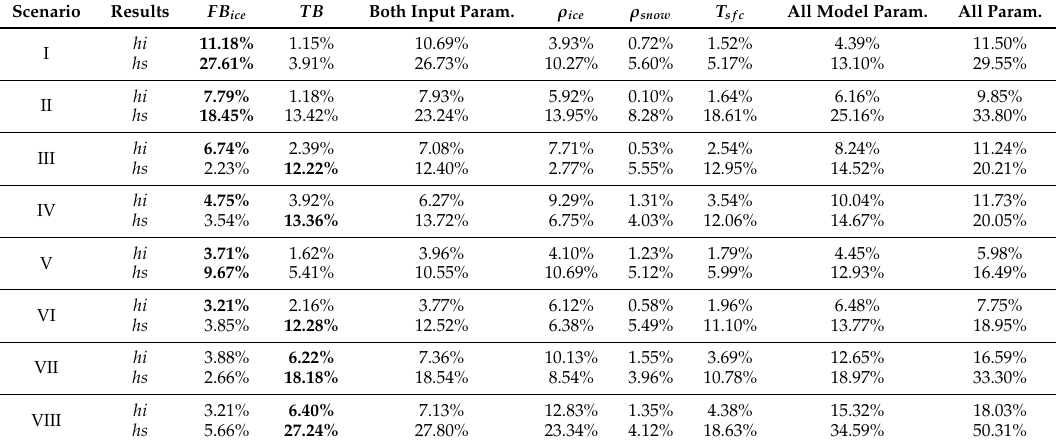
Table 4. Relative uncertainty (units: %) in the retrieved hi and hs for the synergy between TB and FB ice , as estimated by Monte-Carlo simulations. Normal Arctic winter condition is assumed (surface temperature of 30 ◦ C). In each Monte-Carlo simulation sample, the retrieval process is carried − out with a random perturbation to the designated parameter(s). The perturbations are Gaussian, with the standard deviation in Table 3. The relative uncertainty (cid:101) relative is given by: σ y 100%, where σ y y × | y is the standard deviation of y estimated from samples of the corresponding Monte-Carlo simulation, and y the true value ( y for hi or hs ). Sensitivity studies are carried out for each input or model parameter, each set of parameters, as well as all parameters (in different columns). The numbers in bold are the relatively larger one between the two values associated with the input parameters.